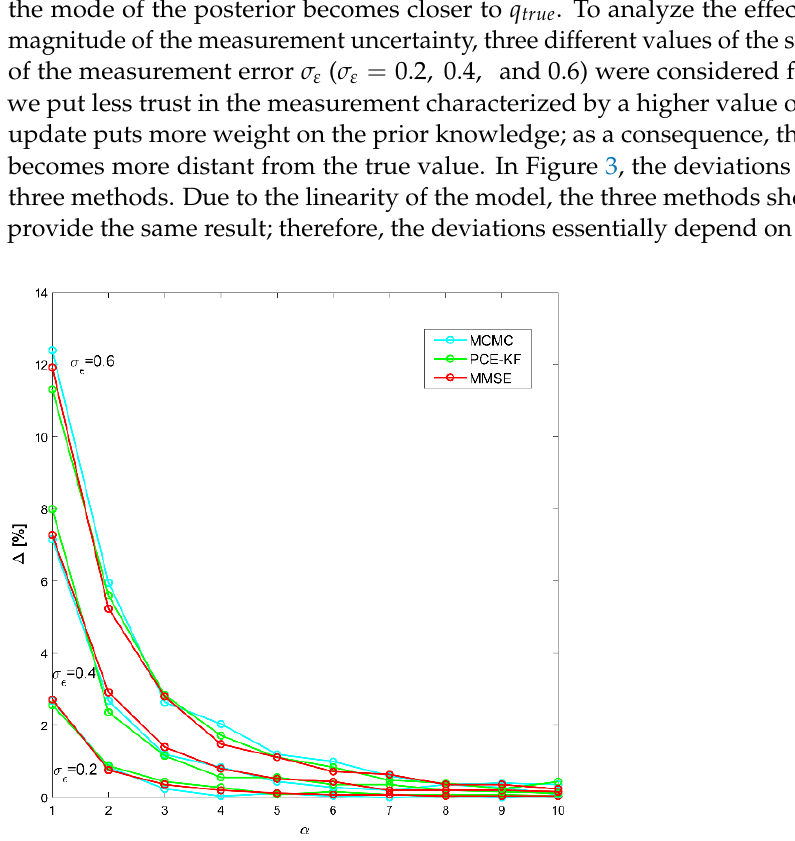
Figure 3. Percentage deviation ∆ % in the updating plotted as a function of the slope α of the linear model (Model 1) and the measurement error σ ε ( q true = µ + σ ). Results are compared for the MCMC method (in cyan), the PCE-KF method (in green) and the NL-MMSE method (in